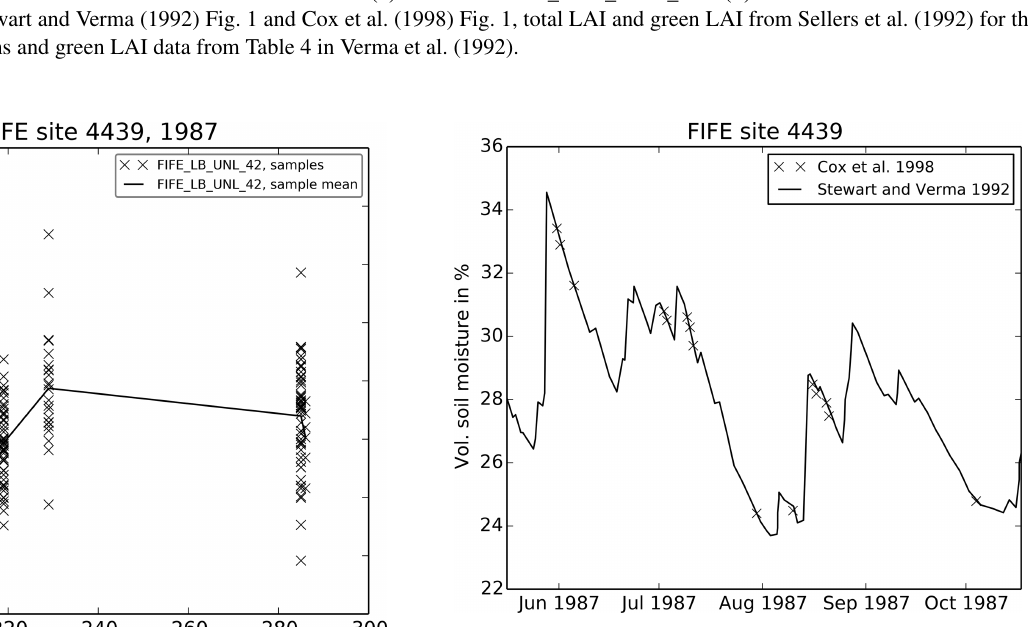
Figure A3. Soil moisture data from Cox et al. (1998), compared to the derived time series of top 1.1m soil moisture in Fig. 1 of Stewart and Verma (1992). Both datasets are for FIFE site 4439 in